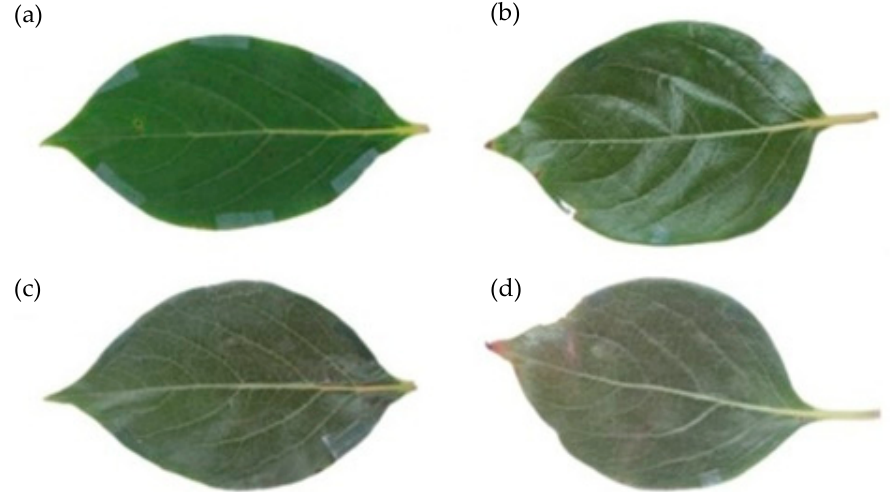
Figure 1. Persimmon leaves collected in ( a ) April (after flowering), ( b ) July (70% fruit size), ( c ) October (fruit at harvest) and ( d ) November (lethargy).